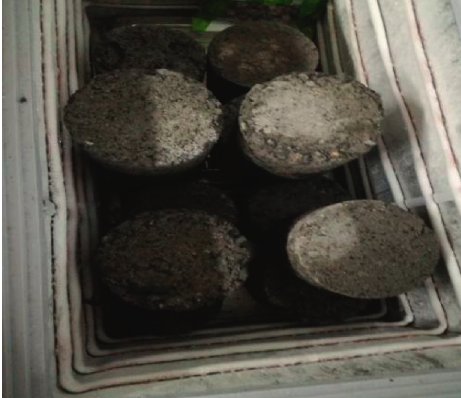
Figure 9: Freezing and thawing process.